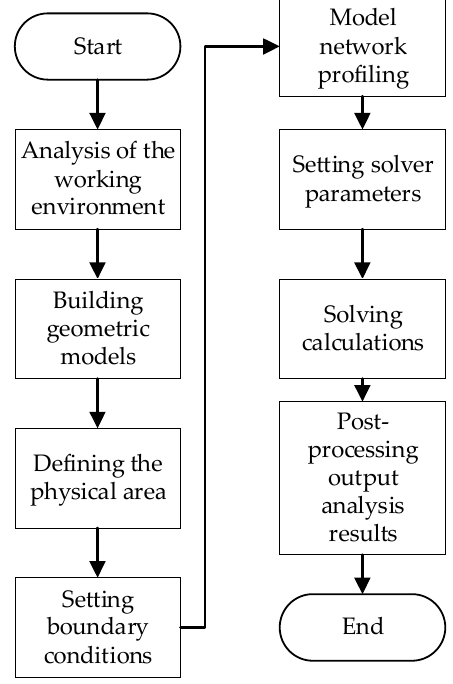
Figure 2. Simulation flow chart.